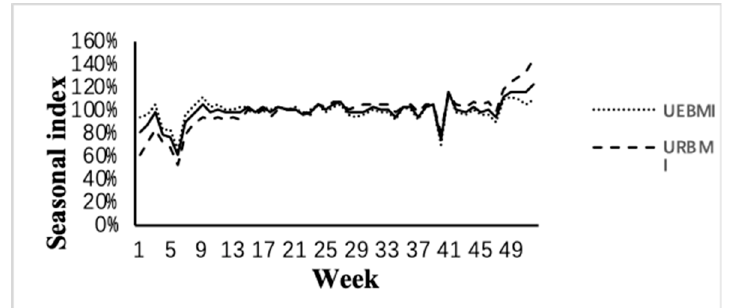
Figure 1. Seasonal index sequence.